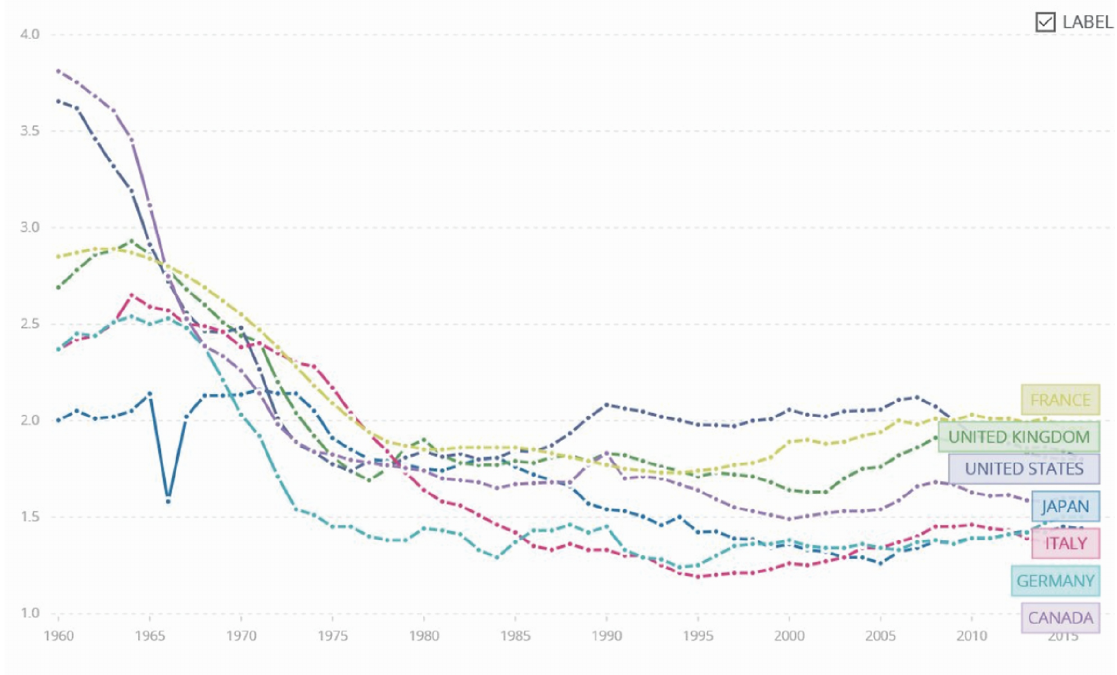
Figure 1. Fertility rate, total (births per woman) for G7 countries. Source: The data up to 2017–1959 are based on the World Bank Data Bank and created through their website (https://data.worldbank. org/indicator/SP.DYN.TFRT.IN, accessed on 28 January